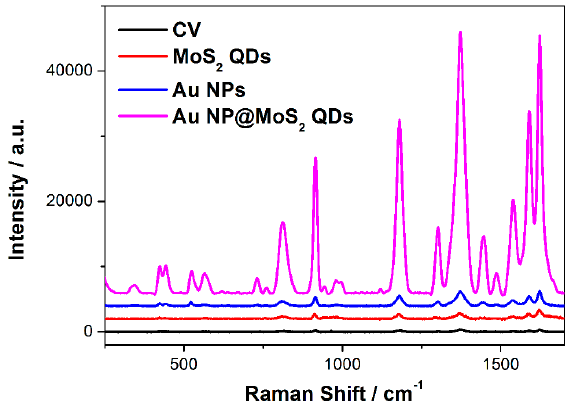
Figure 2. SERS spectra of 5 μ M CV in Au NP@MoS 2 QDs, MoS 2 QDs, and Au NPs aqueous solution, and the normal Raman spectrum of the 1 mM CV aqueous solution.